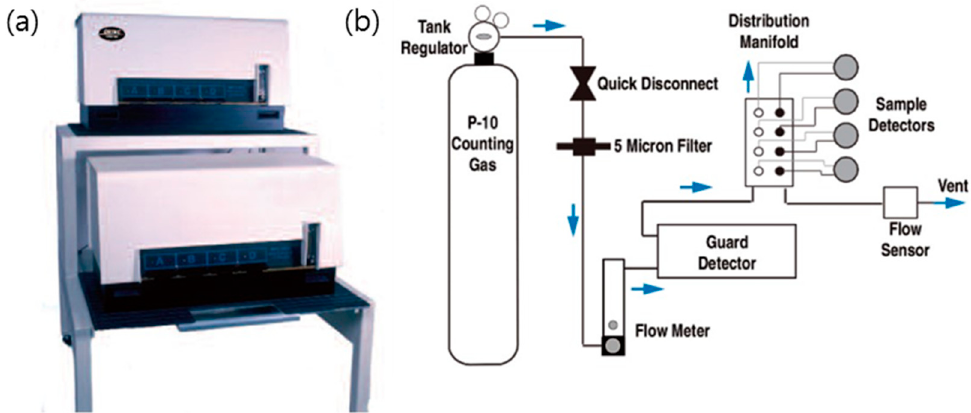
Figure 9. Gas-flow type proportional counter: ( a ) MPC-9604 and ( b ) multi-detector system (MDS) composition linked with a P-10 gas tank [72].